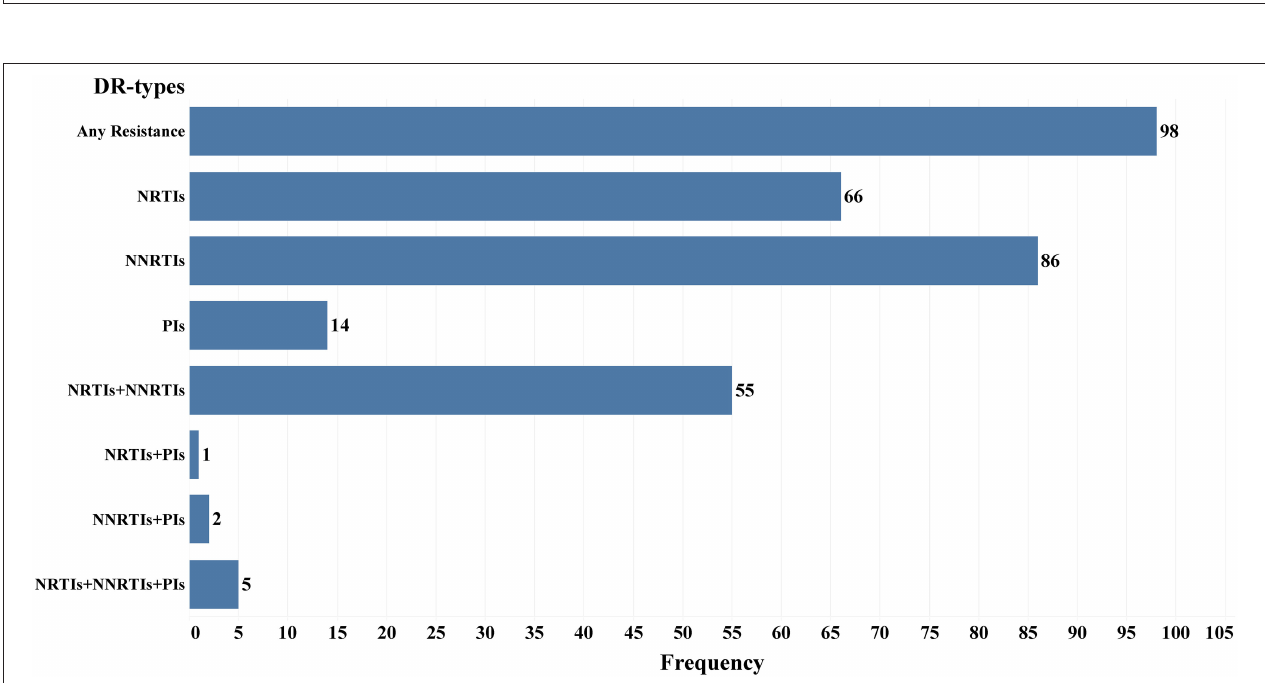
FIGURE 3 | Frequency of different drug resistance types in 98 Drug resistance LLV patients in Jiangsu Province, China.